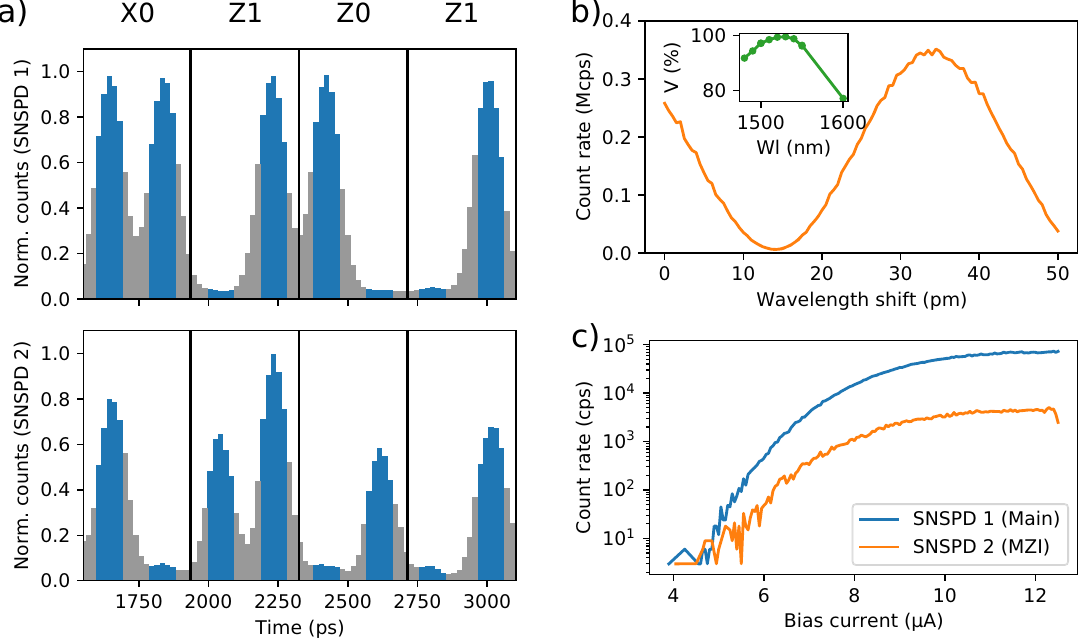
Fig. 4 Detector characterization and histogram. a Excerpt of a histogram of the clicks of the main detector (top) and the monitor detector after the MZI (bottom) when sending a pseudo-random pattern. During the post-processing phase, a gating window is applied such that only the counts in the center of each time bin are counted (blue), while the other counts are ignored (gray). This reduces both the count rate and the error rate and maximizes the secret-key rate when the optimized window width is chosen. b Count rate vs. wavelength around a center wavelength of 1550 nm for SNSPD 2, measured with an incident fl ux of 10 8 photons per second. The MZI visibility was determined to be 96.4% at 1550 nm and 99.6% at 1530 nm. Inset: The visibility V of the MZI over different wavelengths. c Countrate vs. bias current of both SNSPDs with an incident fl ux of ~10 6 photons per second at 1550 nm through input port P1. SNSPD 2 shows a considerably lower count rate due to the splitting ratio of S1 and the MZI in front of the QKD transmission. This can be used to gain a better under- standing of the contributions of the different error sources and to bound the in fl uence of the receiver chip on the error rate, as described in the next section. For each level of attenuation in the quantum channel we integrate over a time span of 5 min. The histogram is recorded with a bin width of 19 ps, such that ~10 bins correspond to a protocol time-bin and are resampled to match the protocol bins during the post-processing step. Although the SNSPDs are operated in a free-running mode, post-selecting events which are centered in the respective time bins can be advantageous for the resulting secret-key rate. This is implemented in software on Bob ’ s side by only choosing a subset of the recorded histogram bins and the resulting bin size is tuned depending on the results of the parameter estimation. This is also exemplarily illustrated in Fig. 4a, where the histogram bins in blue are considered in the evaluation, while counts in the gray bins are omitted.